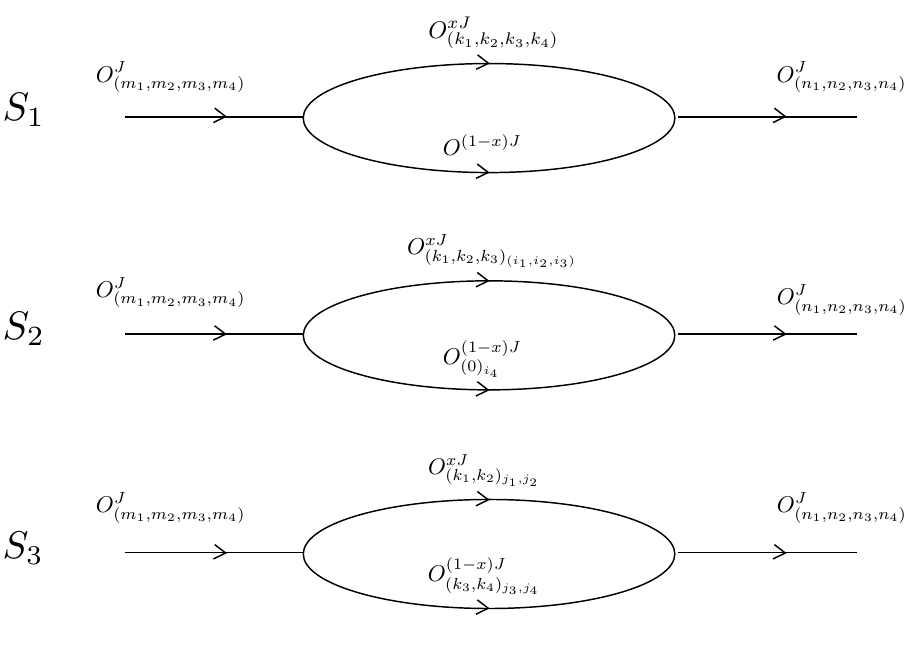
Figure 3 . The one-loop string